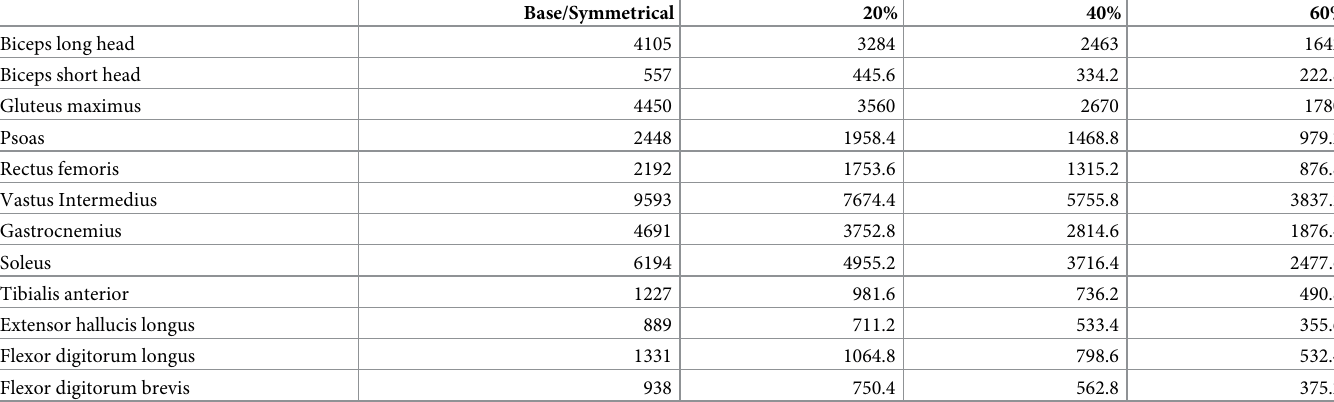
Table 1. Peak isometric strength (in N) for each of the 12 muscles for each model. The right limb strength remained unchanged (Base values) while the left limb strength was modified for the 20%, 40%, and 60% weakness